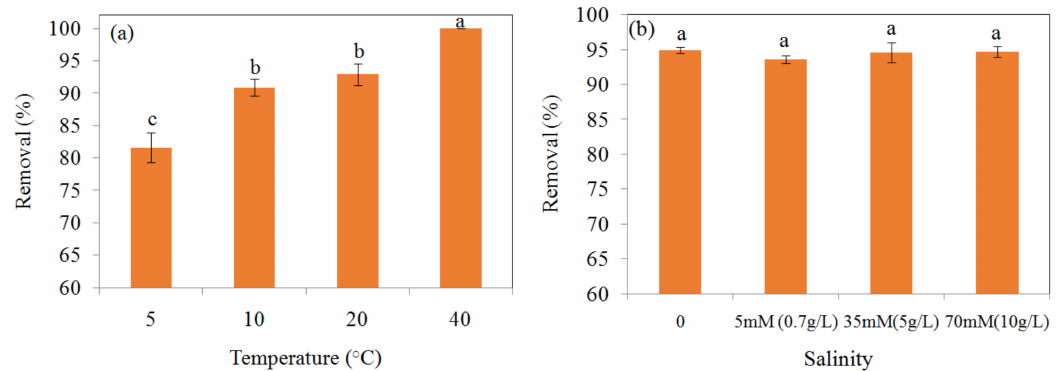
Figure 7. E ff ect of temperature on removal e ffi ciency of Cr(VI) 100 mg / L by MSB300 ( a ), and e ff ect of high salinity on removal e ffi ciency of Cr(VI) 100 mg / L by MSB300 ( b